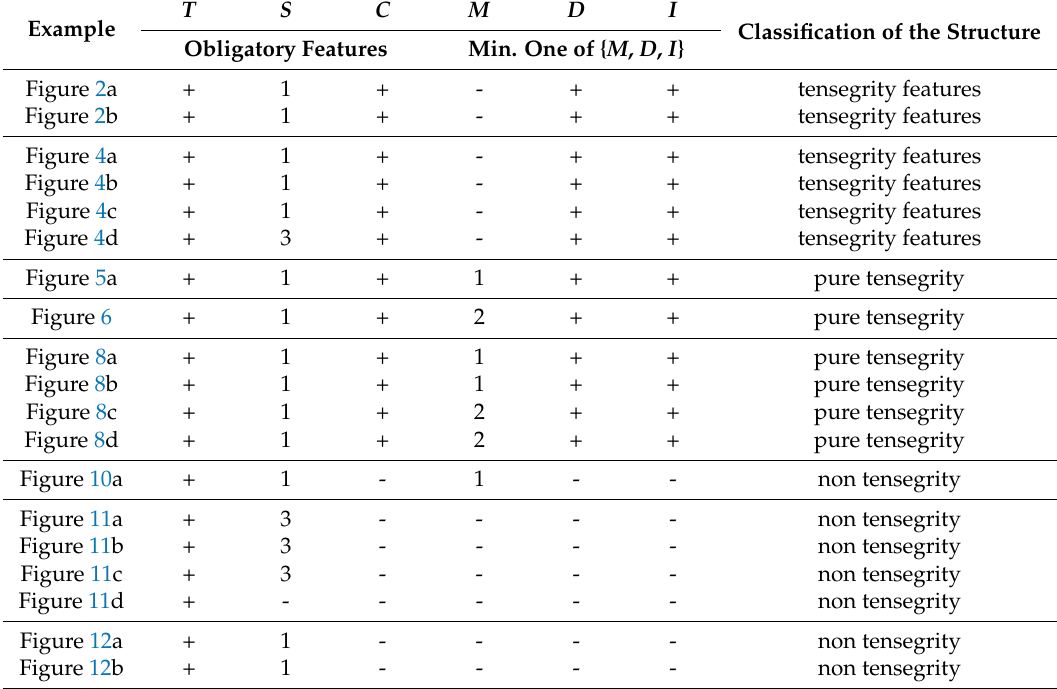
Table 1. Summary of the